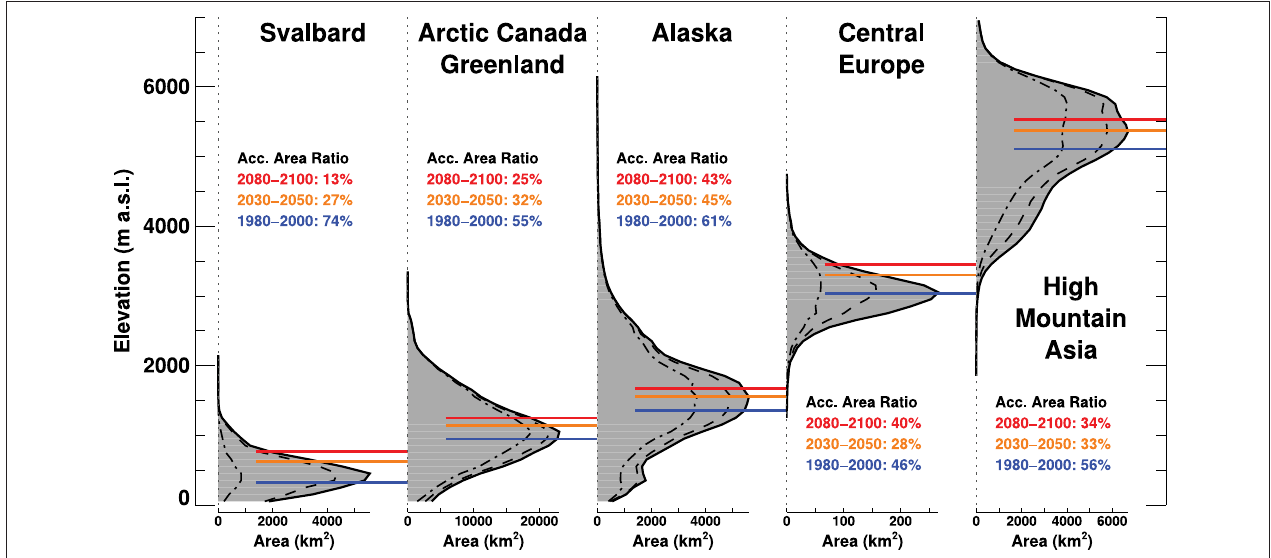
FIGURE 14 | Glacier hypsometry (in 100m elevation bins) for selected regions at present (shaded), and modeled for 2050 (dashed) and 2100 (dash-dotted) using CNRM-CM5 forced by RCP4.5. The ELA is indicated with solid lines and the corresponding accumulation area ratio is given as a mean for three 20-year periods. ELAs and AARs are area-weighted averages over all glaciers per region.